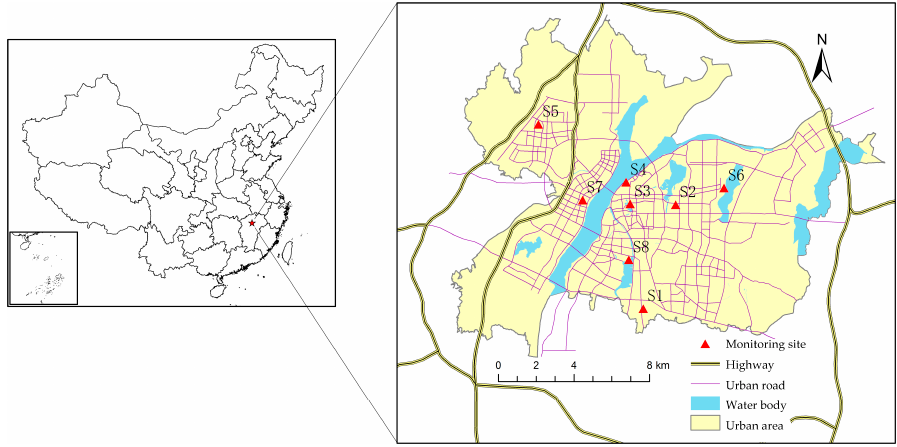
Figure 1. Map of the Nanchang urban area showing the monitoring site locations and road network.